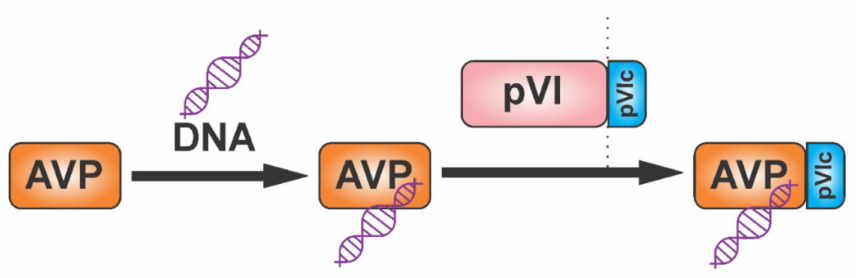
Figure 2. Adenoviruses are characterized by the activation of adenoviral protease (adenain); the activity of adenain (AVP) is stimulated by DNA and by the pVIc peptide released from the pre-pVI protein. Peptide pVIc forms a disulfide bond with adenain and, as a result, increases its proteolytic activity